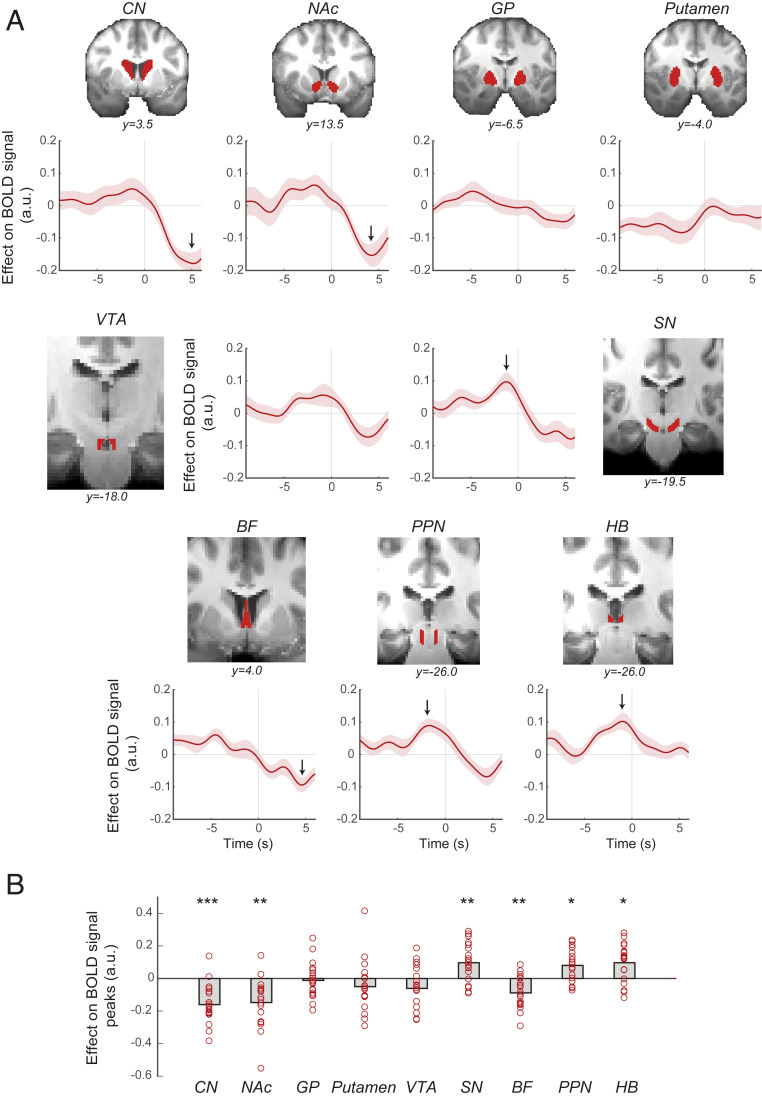
A subset of subcortical structures encodes decision time to act. (A) ROI time course analysis of the a priori selected subcortical structures, showing the relationship between BOLD and observed actTime. The panel next to each time course shows the corresponding anatomical ROI overlaid on averaged structural image of all subjects in standard space. The y axis is based on the FSL MNI152 standard brain in which y = 0 is the dorsal posterior corner of the anterior commissure (ac). Other commonly used atlases such as the Atlas of the Human Brain (43) put y = 0 at the center of ac. The lines and shadings show the mean and SE of the β weights across the participants, respectively. The arrows show the location of the peak effect. Time 0 is the response time. Note that the hemodynamic lag means that a BOLD signal change reflects neural activity ∼6 s earlier. (B) There was a significant relationship between BOLD activity and actTime in CN, NAc, SN, BF, PPN, and HB. However, given the delay in the hemodynamic response, it is clear that the activity in CN, NAc, and BF begins during a late decision phase just before the initiation of action; by contrast, SN, PPN, and HB encode actTime long before the initiation of action during an early decision phase. Each ring represents one participant. The gray columns illustrate the group mean. One-sample t tests with Holm–Bonferroni correction. *P < 0.05, **P < 0.01, ***P < 0.001. See also SI Appendix, Figs. S2–S4.